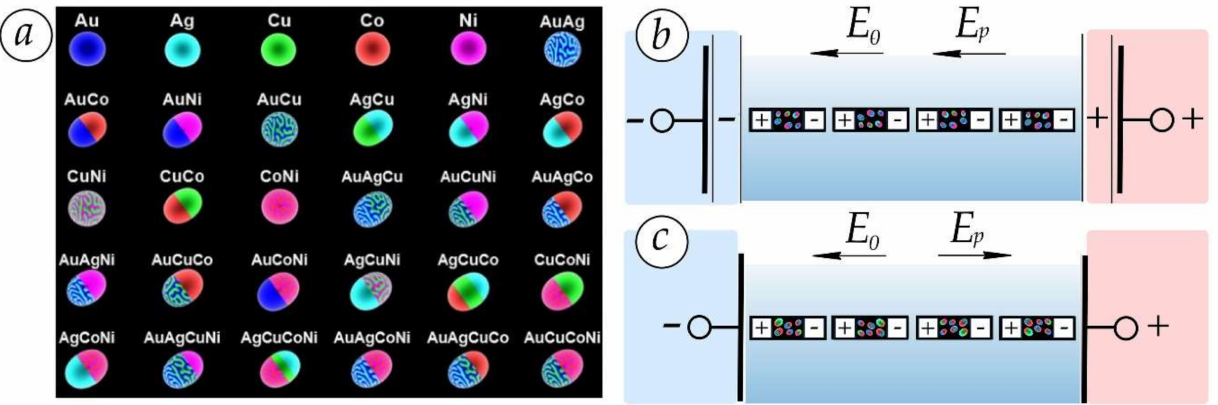
Figure 5. Unary, binary, ternary, and quaternary types of nanoparticles synthesized for industrial application [166] ( a ). Model of a powder in the form of grouped particles chain, the outermost of which are in interaction with devices that have nanoparticles coated with dielectric ( b ) and metal ( c )